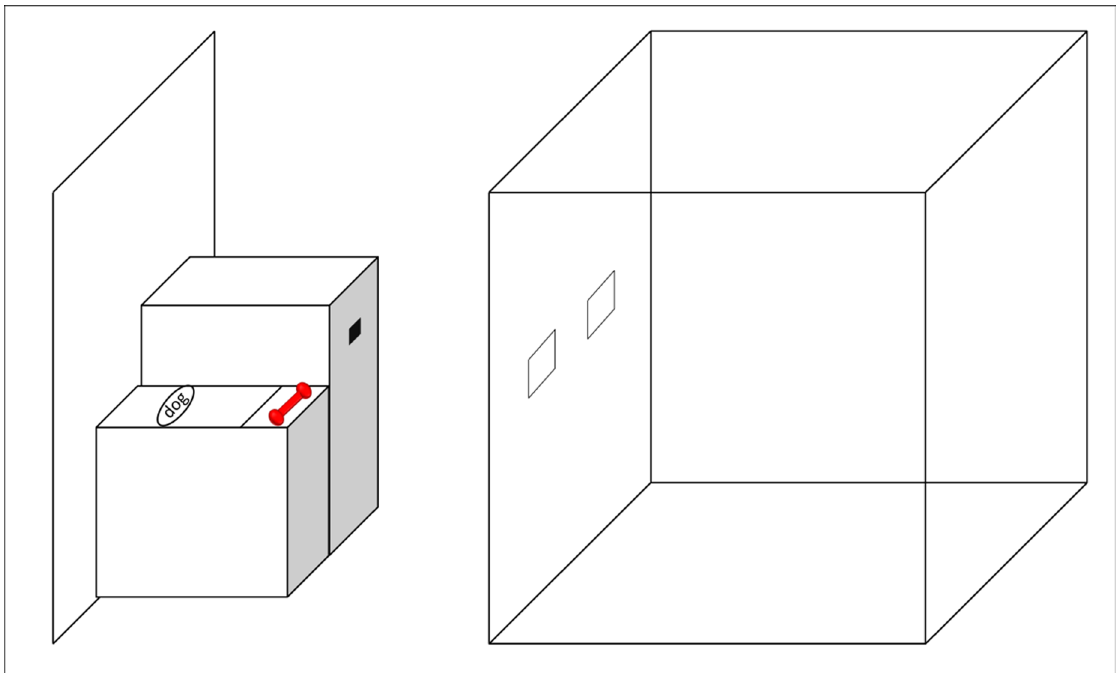
Figure 1. Apparatus used in Experiments 1–5. A depiction of the experimental setup used in Experiments 1–5, consisting of the blicket detector (left) and testing chamber (right). The blicket detector contained a platform for placing objects (location indicated by the red dumbbell), toy dog that lit up and made a sound when blickets were placed on the machine, and an inclined ramp ‘‘grape dispenser’’ that provided monkeys with a food reward when blickets were placed on the